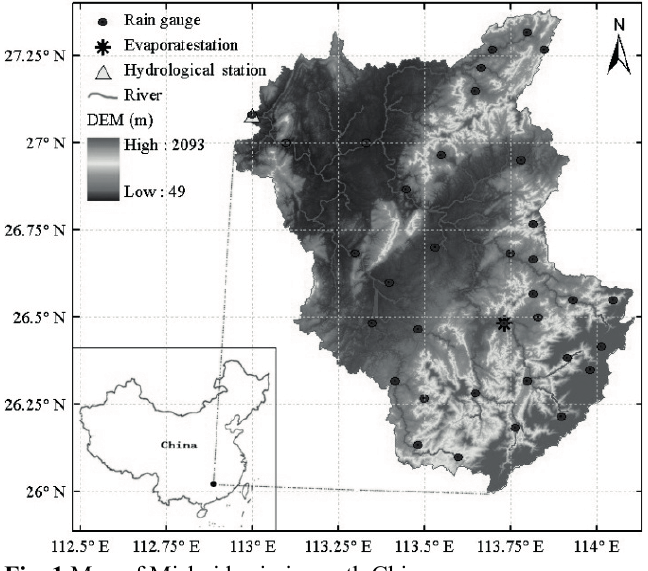
Fig. 1 Map of Mishui basin in south